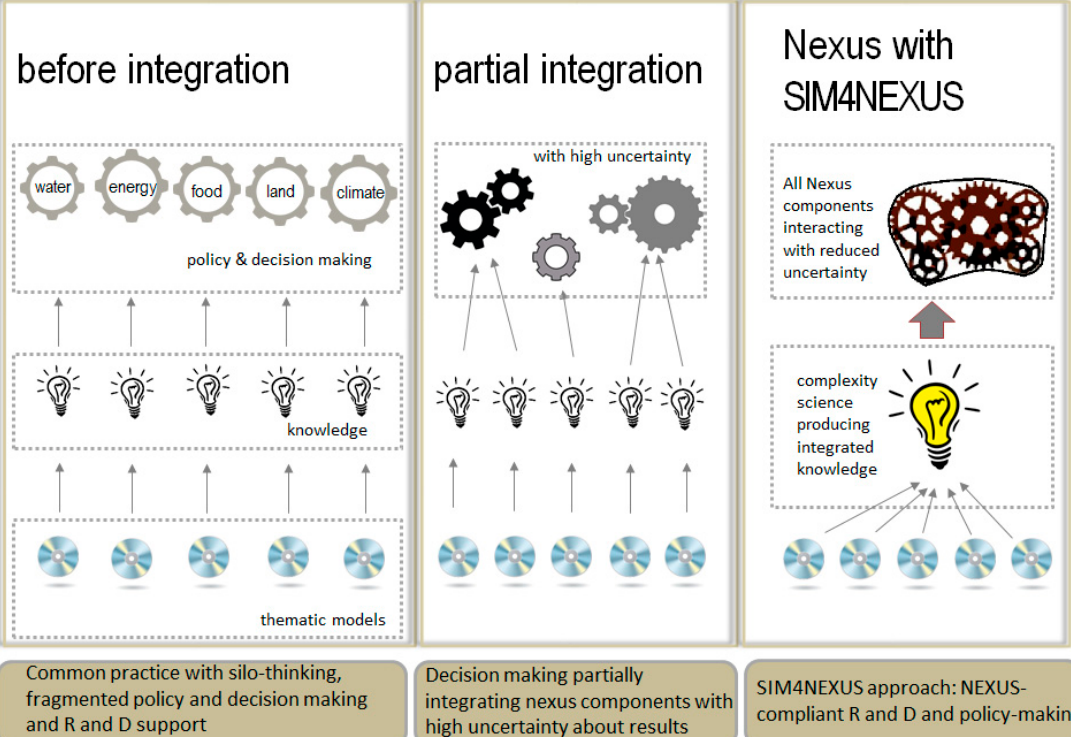
Figure 1. The SIM4NEXUS integration concept.